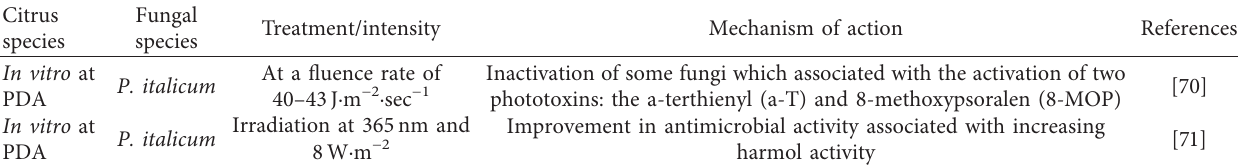
In in vitro studies, fruits were placed 15cm Mandarin P. italicum below UV-B lamps at 15, 30, 60, and 120kJ · m 2 Table 3: Effects of UV-A irradiation on the postharvest rotting caused by P. italicum and P. digitatum .